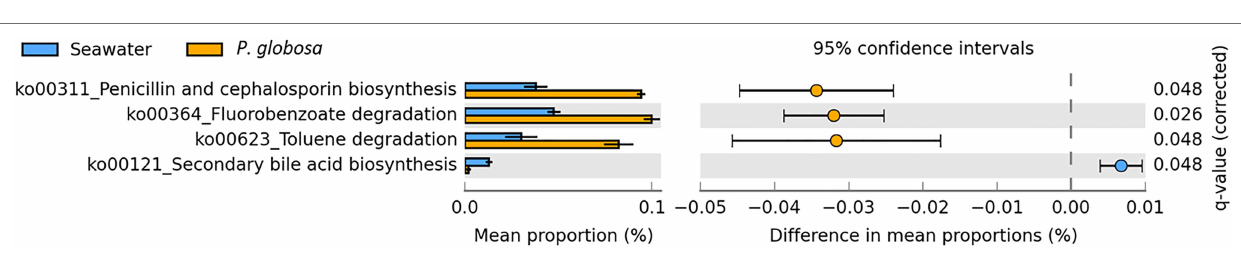
FIGURE 5 | Predicted microbial functions with significantly difference in samples collected from ambient seawater and P. globosa intracolonial fluid. Differential abundance between samples was determined using a two-sided Welch’s t test, with a Storey FDR, adjusted q value <0.05 and followed by an effect size filter (ratio of proportions effect size